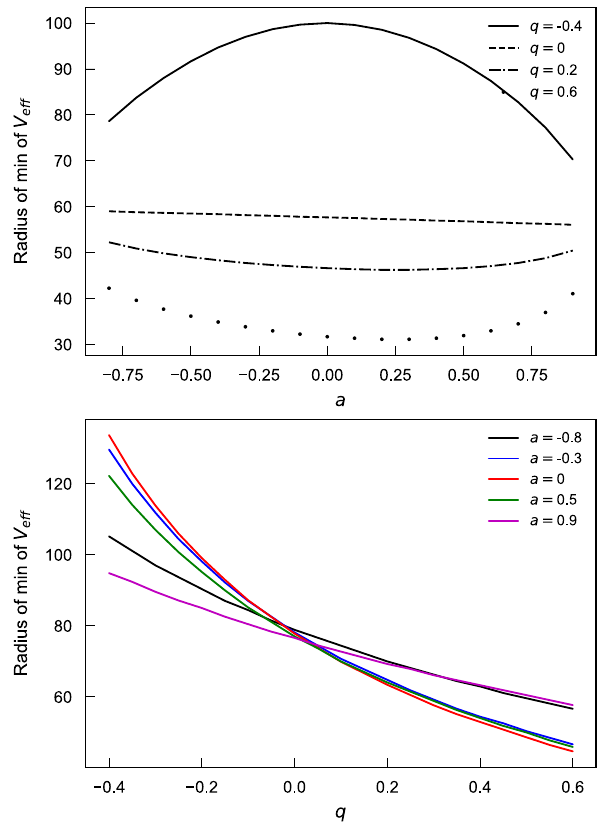
Fig. 6 Top: Minimum of the effective potential versus a for fixed q. Bottom: Minimum of the effective potential versus q for fixed a . The value of L is the same for each plot